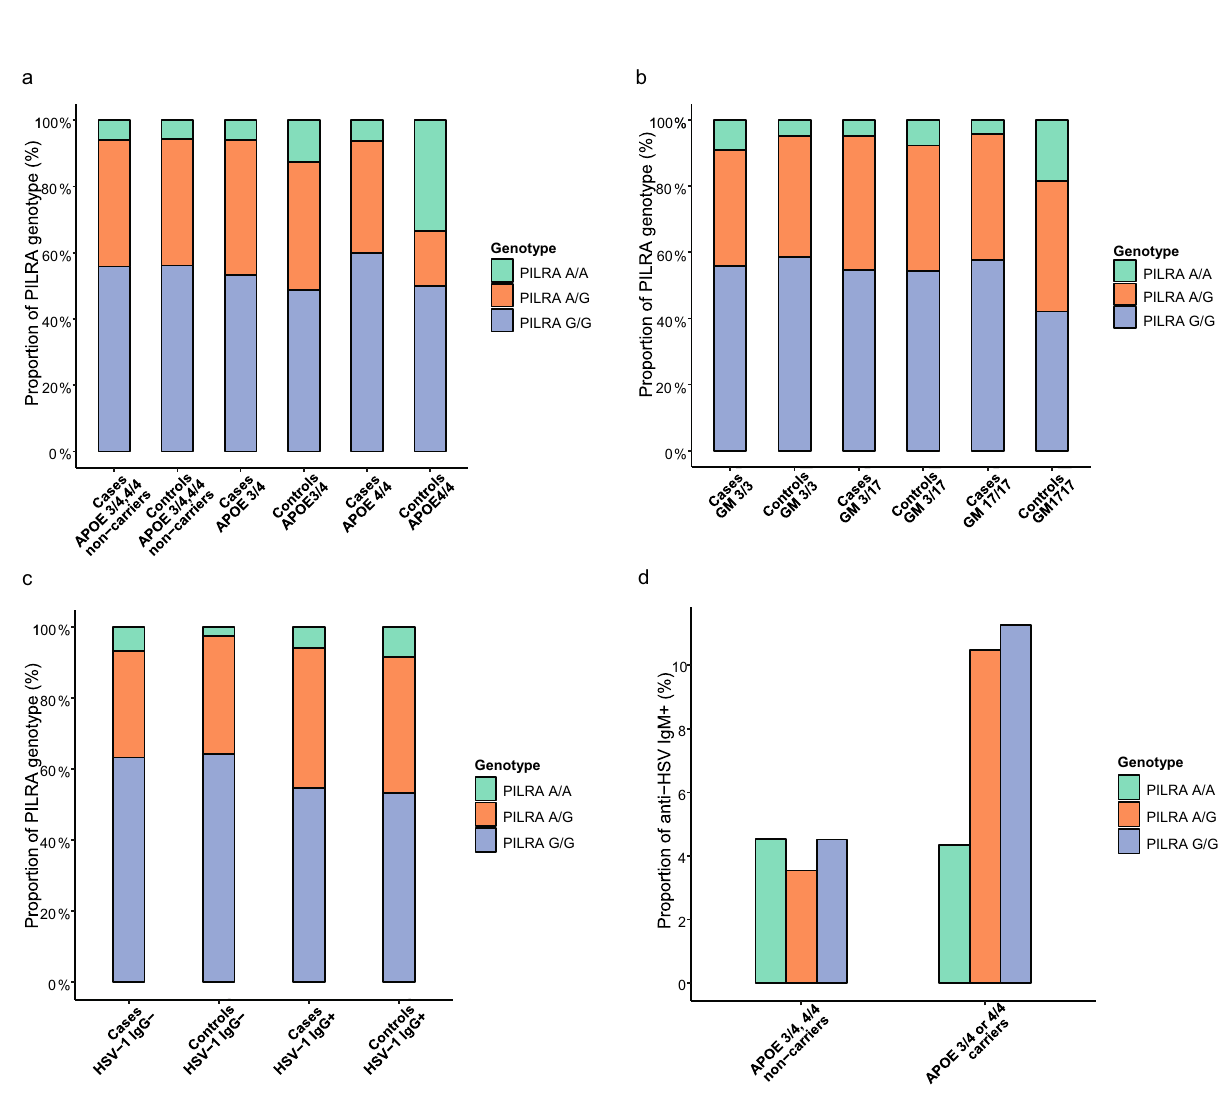
Figure 1. Proportions of PILRA R78G genotype and anti-HSV IgM + respectively. A) Stratified by APOE ε4 genotype and case–control status. B) Stratified by GM genotype and case–control status. C) Stratified by anti- HSV-1 IgG + and case–control status. D) Proportion of anti-HSV IgM + stratified by APOE risk variants and PILRA R78G